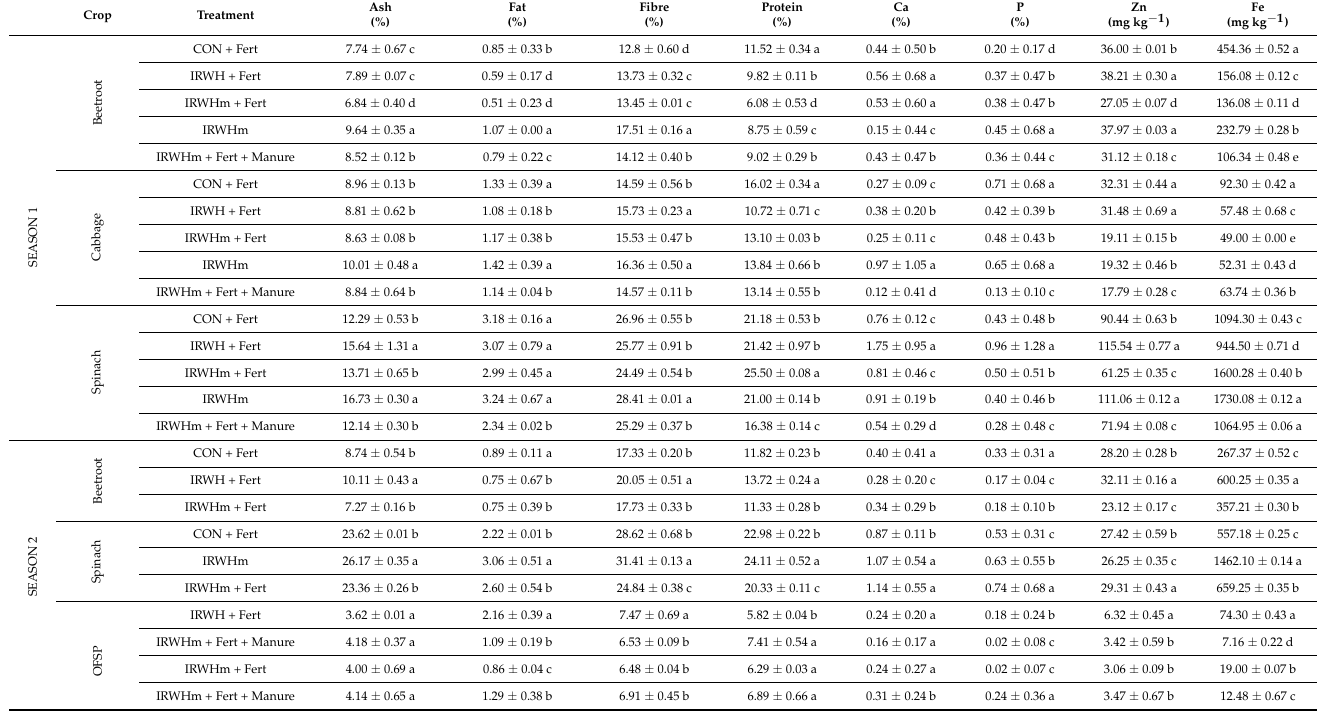
Table 1. Effect of agronomic treatment and water-use technology (either CON or IRWH) on the proxi- mate composition and level (concentration) of individual mineral elements of different vegetables in Swayimane, KwaZulu-Natal province ( w / w , on a dry matter basis, mean ±